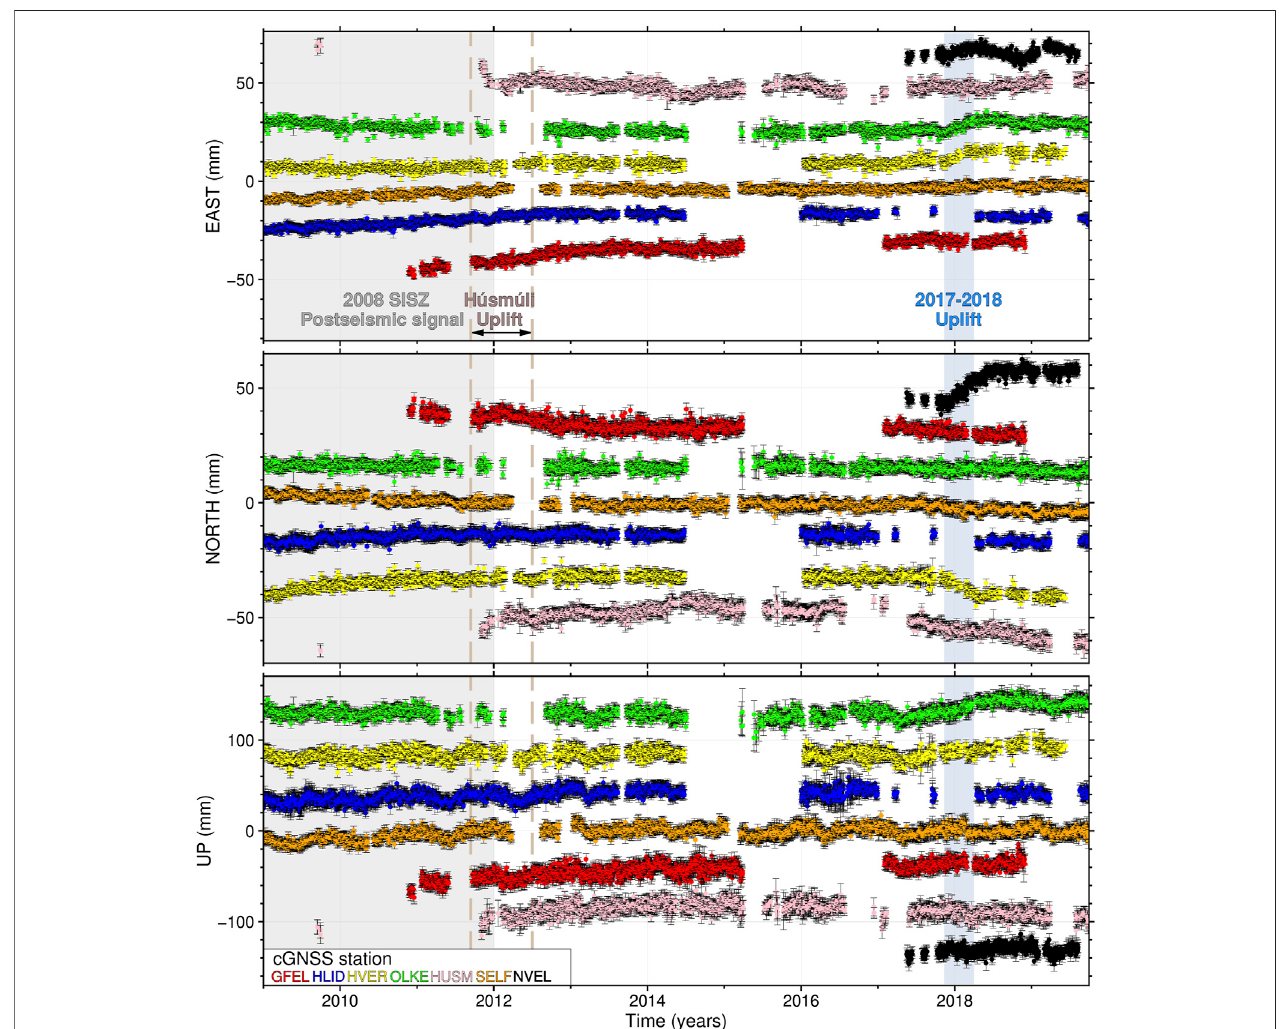
FIGURE3| Time seriesshowing cGNSS station displacements(with 95%error bars) intheHengillarea, inEast, North and Upbetween January 1,2009 and June 30, 2019 (see Figure 1 for station locations). The seven cGNSS stations are: GFEL (red), HLID (blue), HVER (yellow), OLKE (green), HUSM (pink), SELF (orange) and NVEL (black). The time series have been corrected for a linear trend and seasonal signal estimated between March 2012 and January 2017 with the exception of GFEL (June2013 – June2015)andNVEL(June2018 – June2019).ThetimeseriesofGFEL,showsthattheareawhereisthestationlocateddoesnotseemtobeaffected by the uplift in the Eastern part of Hengill, thus making it a reasonable area of reference for our InSAR time series. Stations HVER, NVEL and OLKE show vertical displacements and/or horizontal motions between 2018 and 2019 consistent with an in fl ation episode.